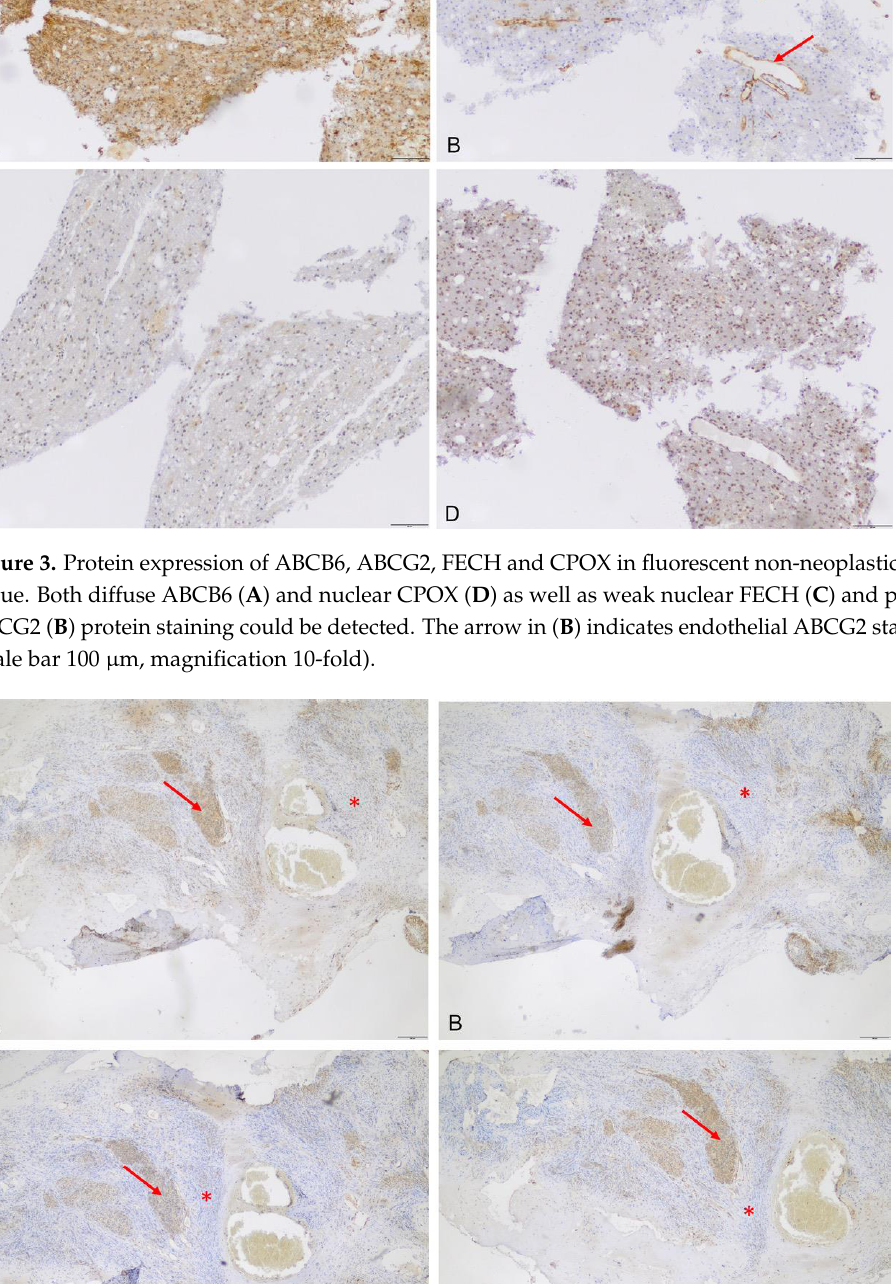
Figure 4. Expression of the analyzed transporters and metabolism enzymes in scar tissue. Protein expression of ABCB6 ( A ), ABCG2 ( B ), FECH ( C ) and CPOX ( D ) is absent in scar tissue (*) but present in the invading meningioma tissue (arrows, scale bar 200 µm, magnification 5-fold).